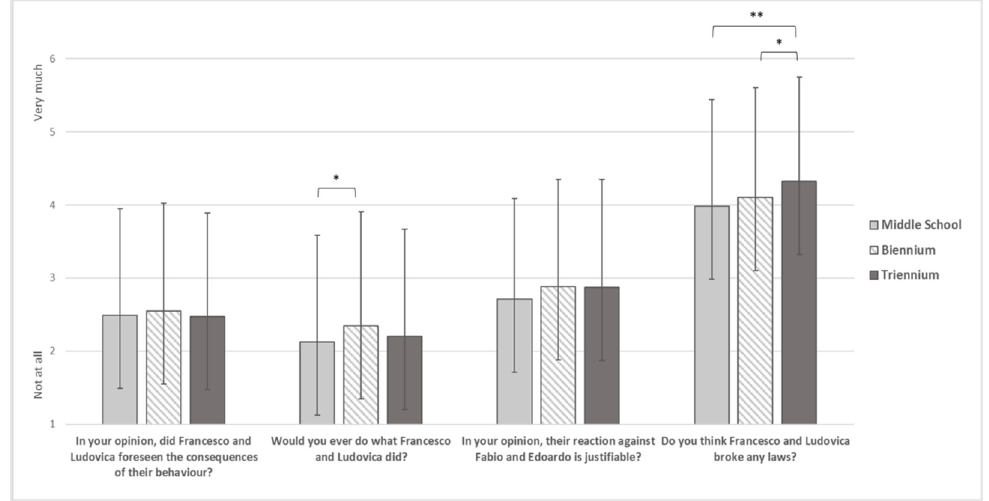
Figure 4. Justification of the harassment by the victim’s friends. Note. * = p < 0.05, ** = p < 0.01.